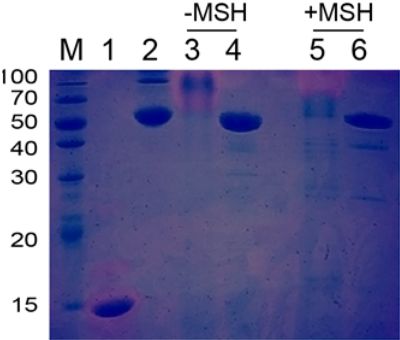
Figure 5. Pancreatin analyzed using the in-gel activity assay with a glycol chitin substrate . Lane 1, lysozyme, as positive control; Lane 2, bovine serum albumin, as negative control; Lane 3, pancreatin; Lane 4, heated pancreatin; Lane 5, pancreatin treated with MSH; Lane 6, heated pancreatin treated with MSH.